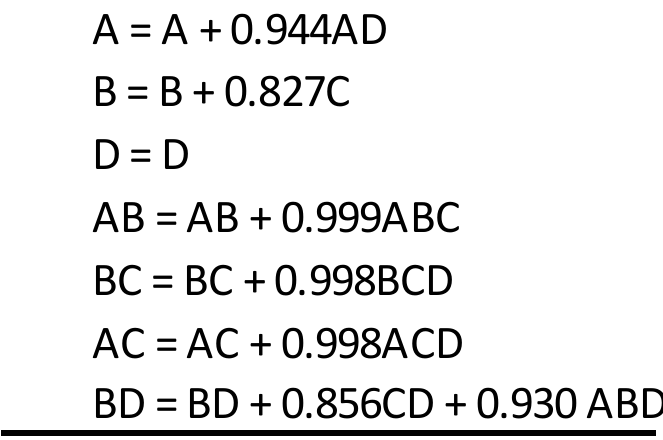
Figure 9. Alias structure for EA (21, 3 2 5 1 7 1 ).